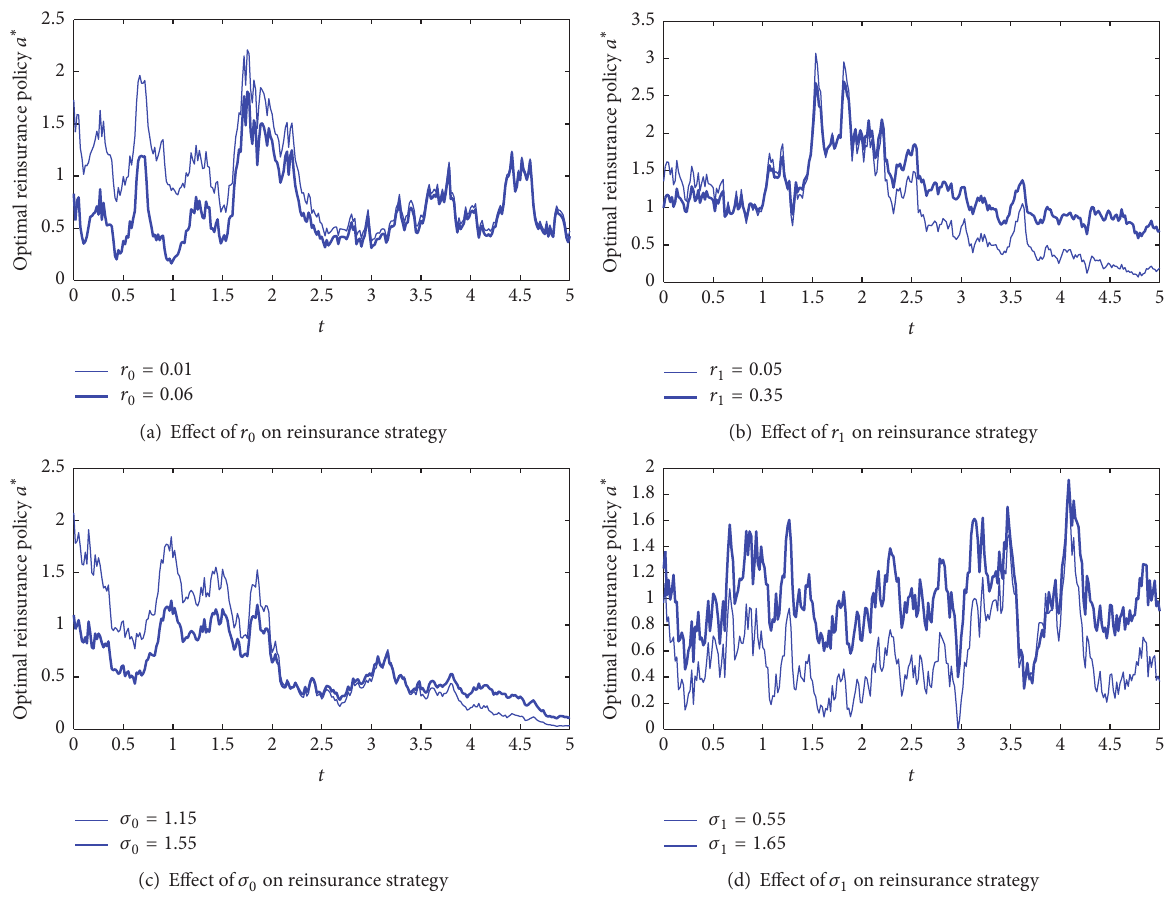
(d) Effect of 𝜎 1 on reinsurance strategy Figure 2: The effect of parameters on optimal reinsurance